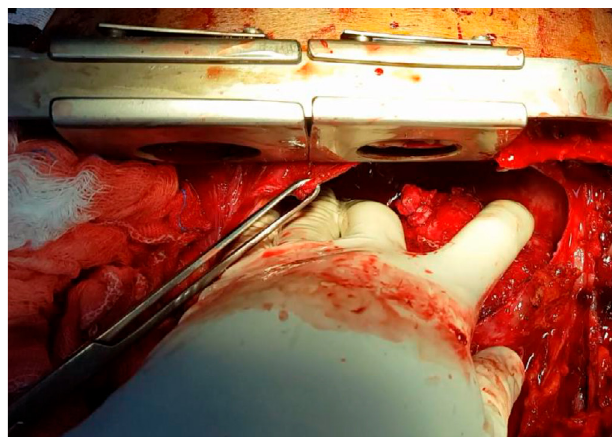
Fig. 3 – Final appearance after pericardial patch on the topography of lesion with 3-0 polypropylene suture.